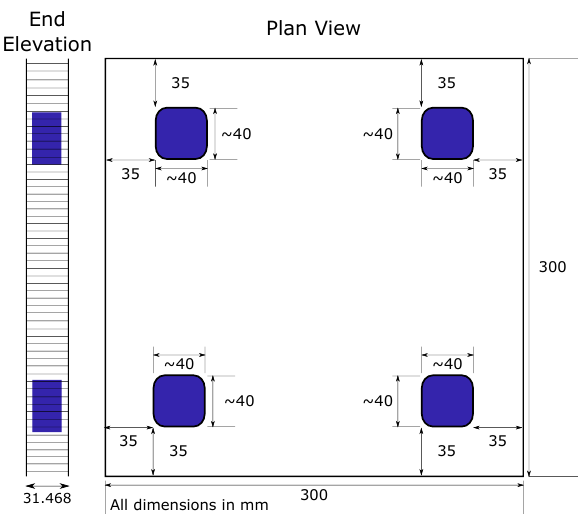
Figure 3. Panel D2 defect locations. Impact damage blue.